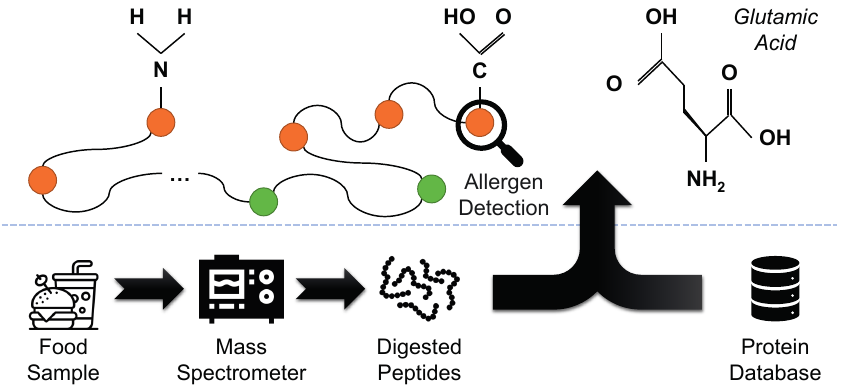
Figure 5. Schematic Representation of Food Analysis to Detect Allergens in a Food